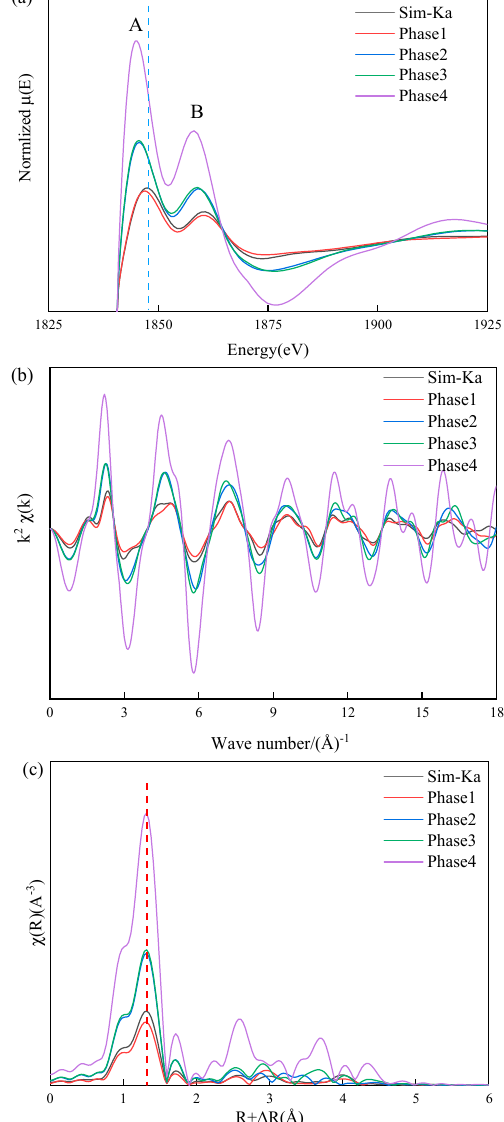
Figure 7. ( a ) The normalized X − ray absorption spectra for the Si K − edge for Sim − Ka, Phase 1, Phase 2, Phase 3, and Phase 4; ( b ) the EXAFS spectrum k 2 χ (k) as a function of the wave vector, k, for the Si K − edge for Sim − Ka, Phase 1, Phase 2, Phase 3, and Phase 4; ( c ) the radial structural function for Sim − Ka, Phase 1, and Phase 2 at the Si K − edge.